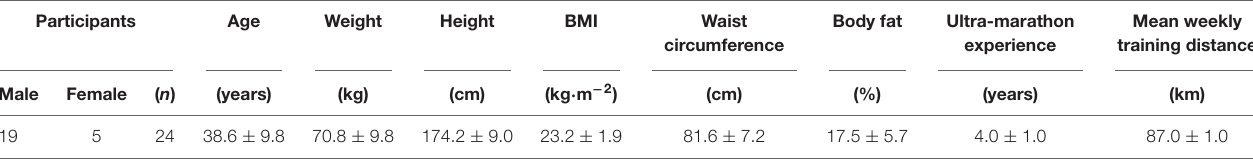
TABLE 1 | Participant